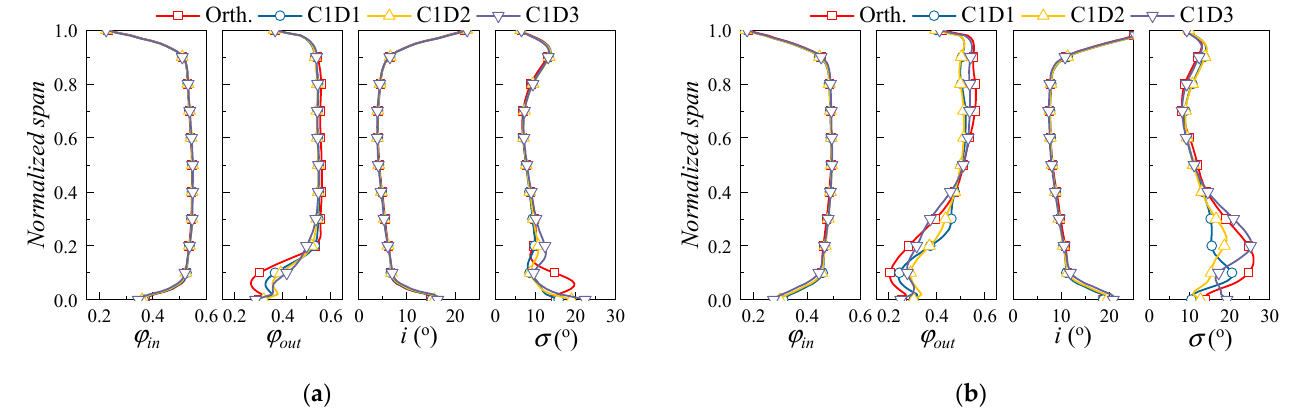
Figure 22. Radial distribution of aerodynamic performances for the cases with different dihedral angles. ( a ) φ = 0.52; ( b ) φ = 0.46.